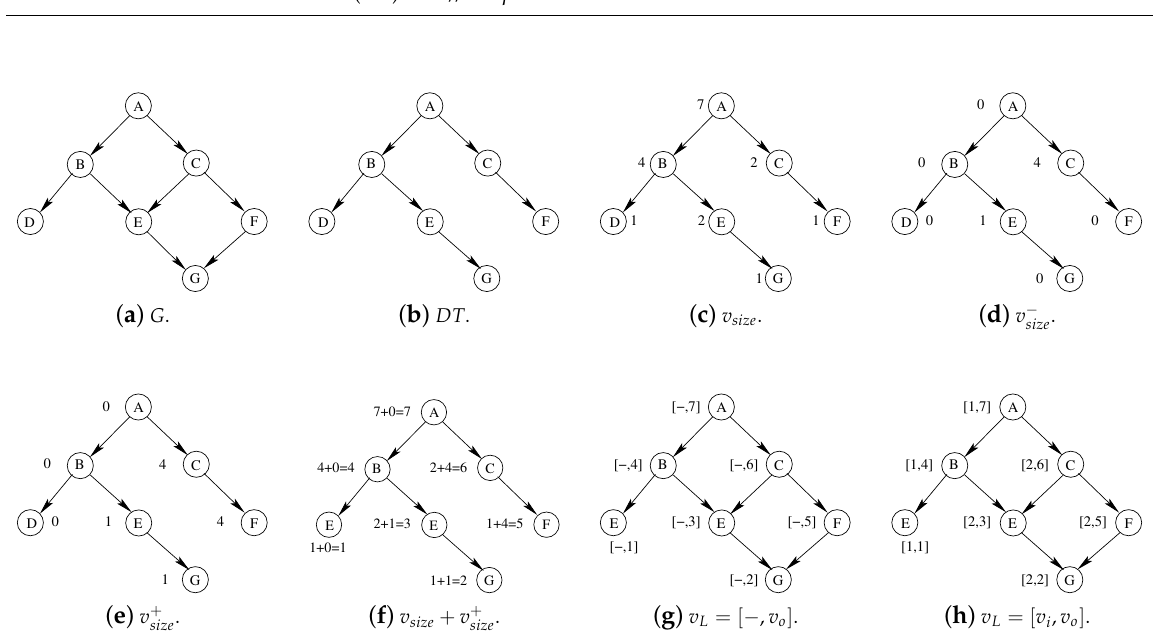
Figure 3. A step-by-step representation of the entire process necessary to compute a single label pair for each vertex of the graph G of Figure ( a ). Step 1 (Figure ( b )): Represents the directed tree DT corresponding to the original graph G once the selection of a single parent for each vertex has been performed. Step 2 (Figure ( c )): The attribute v size stores, for each vertex v of the DT, the size of the subgraph rooted at v . Step 3 (Figure ( d – g )): The attributes v − post-order values v o are reported for each vertex v following the main inner steps performed by the third BFS procedure. Step 4 (Figure ( h )): The final min-post labeling v L = [ v i , v o ] obtained by the procedure C OMPUTE M IN P OST L ABELING of Algorithm